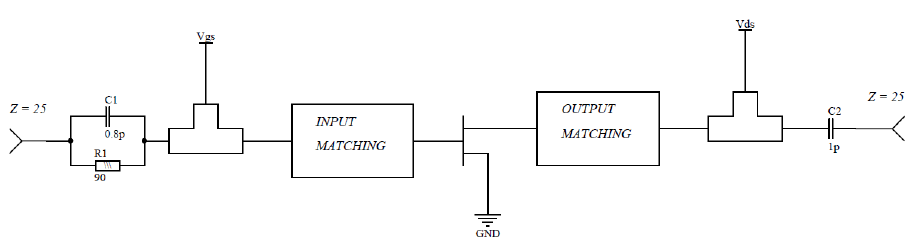
Fig. 3. Block diagram of matching the amplifier stage.